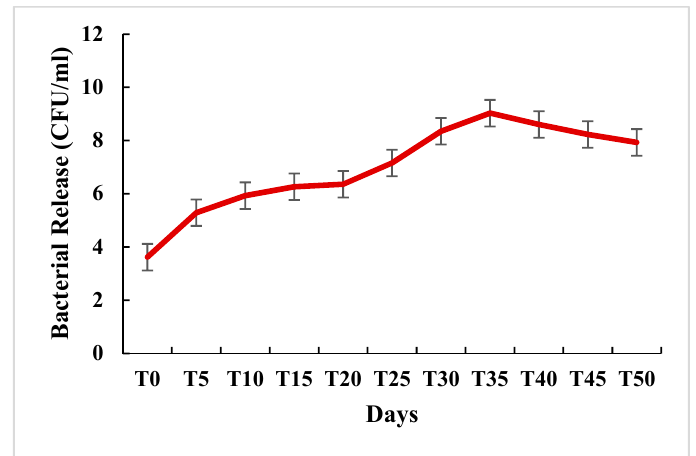
Figure 7. Release of S. fulvissimus Uts22 from microcapsules in phosphate buffer .